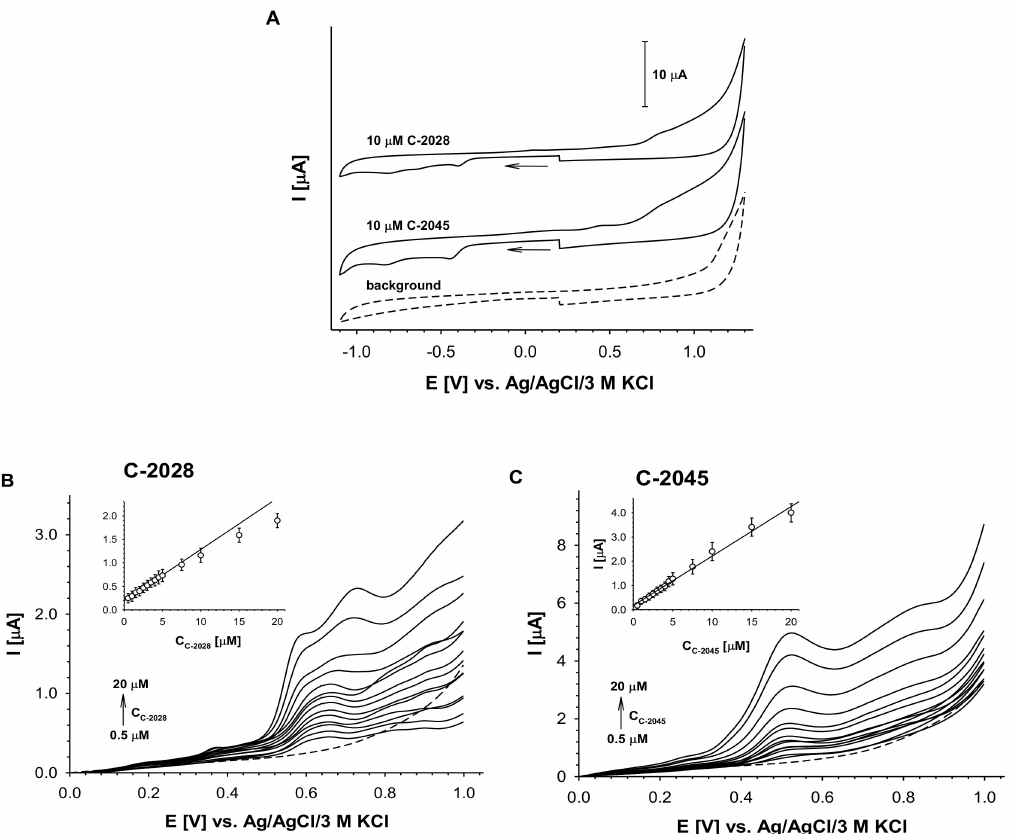
Figure 2. Electrochemical analysis of C-2028 and C-2045 compounds. ( A ) Cyclic voltammograms of two UAs compounds (cUAs = 10 µ M) in comparison to the background. ( B ) C-2028 and ( C ) C-2045 DP voltammograms. The solutions were prepared at least 1 h before measurements. Insets in B and C: dependence of DPV peak current intensity vs. UAs concentration. Experimental conditions: cUAs = 0.5–20 µ M, 0.02 M borate buffer with 0.15 M NaCl, pH 7.4, glassy carbon electrode ( φ = 3 mm), scan rate: 100 mV/s, pulse time 0.01 s, interval time 0.1